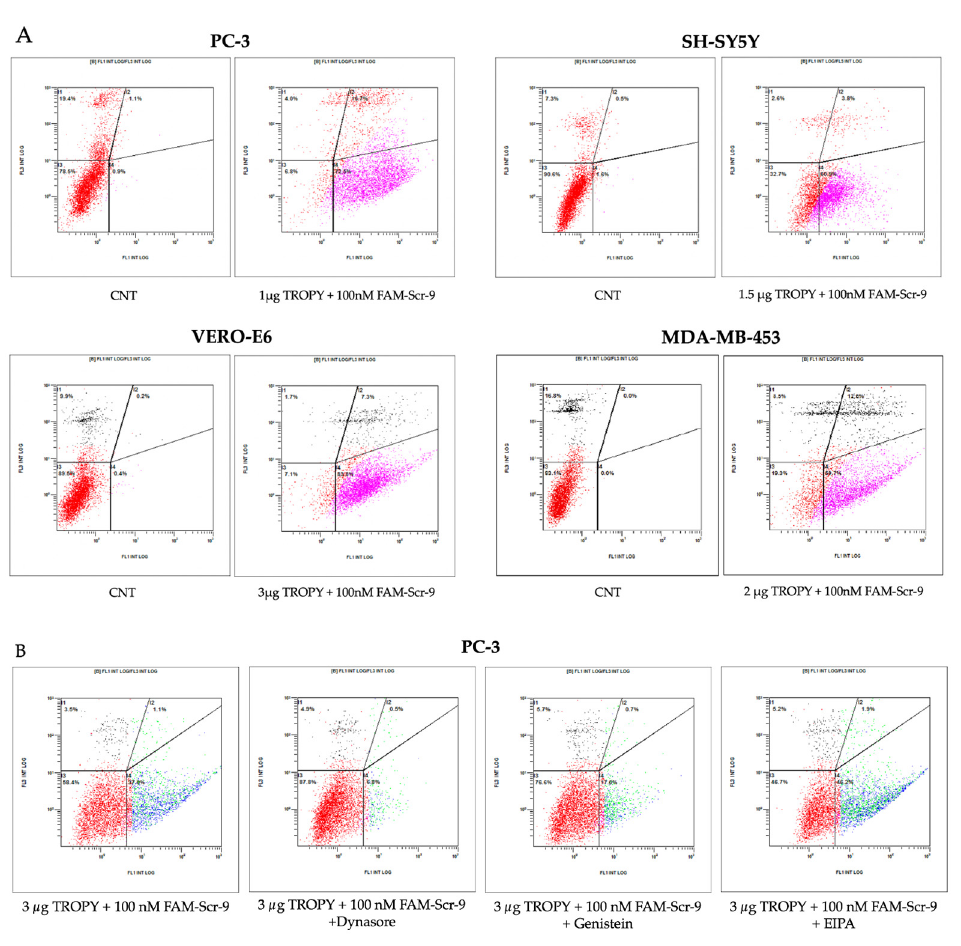
Figure 5. Cellular uptake by flow cytometry. ( A ) The uptake of the fluorescent PPRH is shown in four different cell lines incubated in 1 mL of culture medium for 24h with the indicated amounts of TROPY. The screening generated by flow cytometry analyses divided the cell population into quadrants. The upper and lower right quadrants represented the internalization of positive-gated cells with the fluorescent TROPY–HpScr9 complex. The lower left represents the autofluorescence of the cells, and the upper left, the dead cells stained with propidium iodide. In all cases, we visualized a shift of the cell population to the right when comparing the fluorescence of the incubated cells to that of the control. The increment was quantified by the green fluorescence of FAM-HpScr9. ( B ) Endocytic pathways involved in the internalization of the TROPY/PPRH complexes. PC-3 cells were incubated for 1 h with 75 µM of Dynasore, 185 µM Genistein, or 33 µM EIPA and subsequently transfected with 100 nM of the FAM-HpsPr-C PPRH using 2.1 µM of TROPY. After 3.5 h of incubation, the percentage of fluorescent cells and the mean fluorescence of the PC3 cells were determined by flow cytometry. In ( A ), the fucsia represents the internalized fluorescent cells, whereas in ( B ), the blue colour represents the internalized fluorescent cells in the experiments using endocytic pathways inhibitors. The red in CNT is the